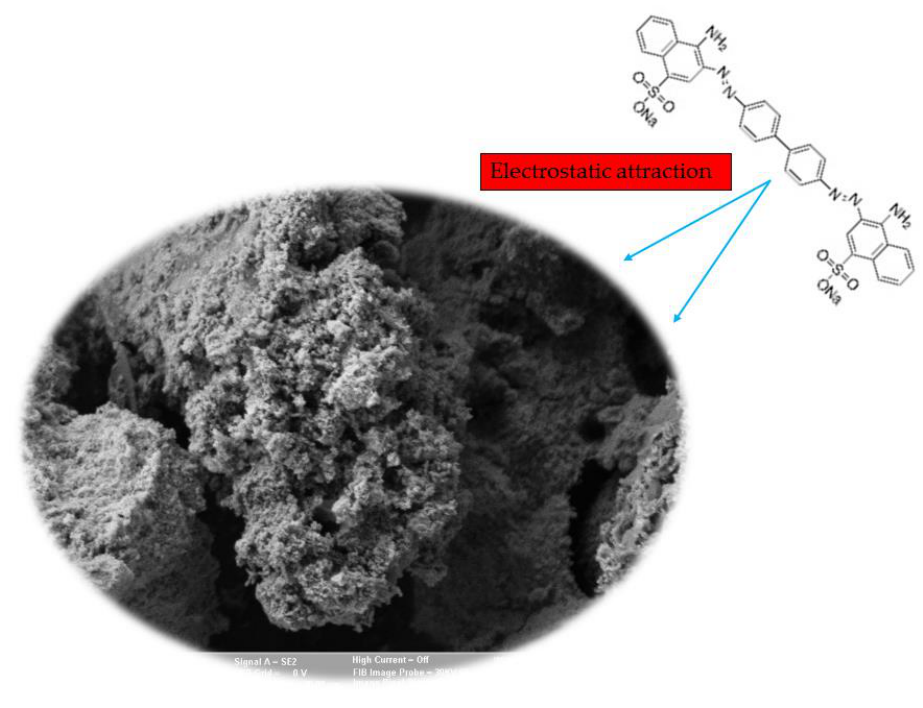
Figure 5. The proposed adsorption mechanism of Congo red dye by Fly-ash@Fe 3 O 4 .